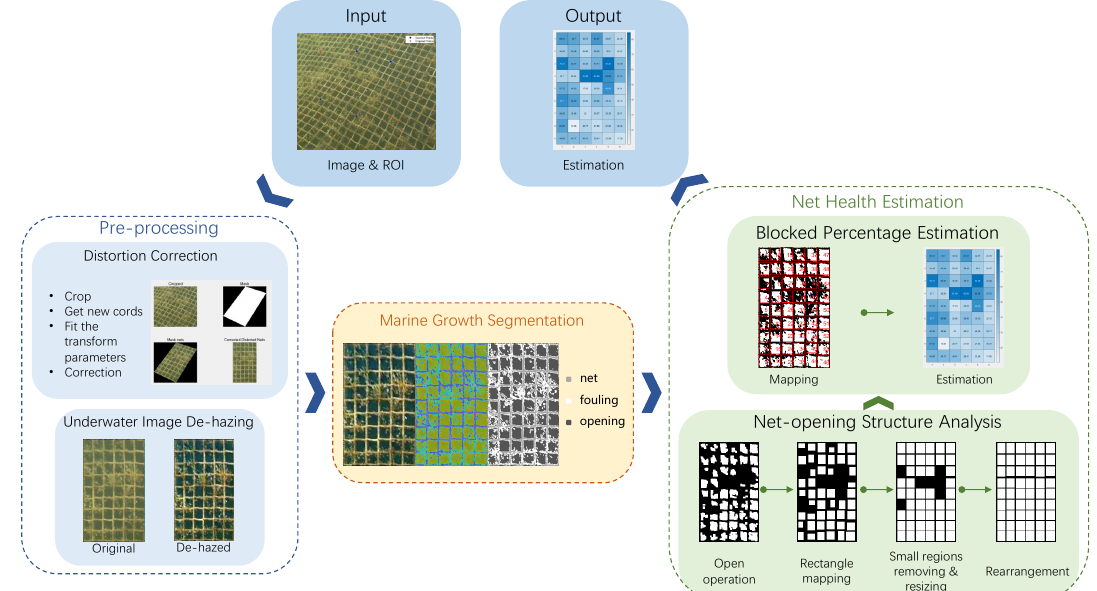
Figure 1. Framework of underwater fishing net health state